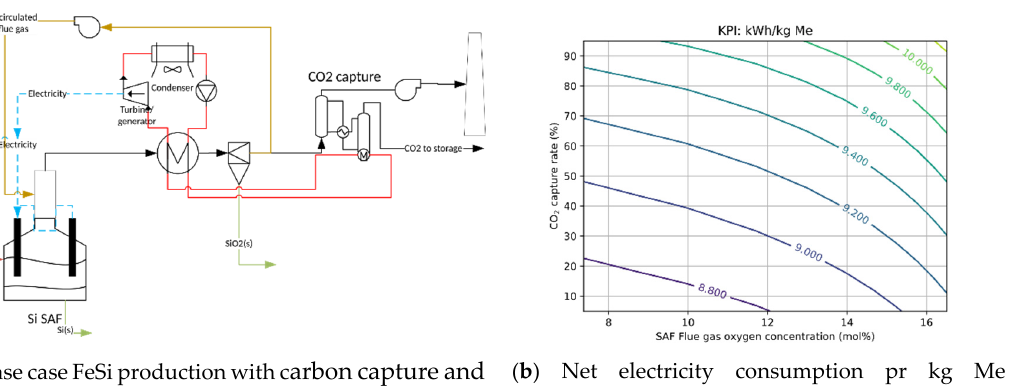
Figure 10. FeSi production integrated with CO 2 capture process. See Tables 2 and 3 for design parameters.